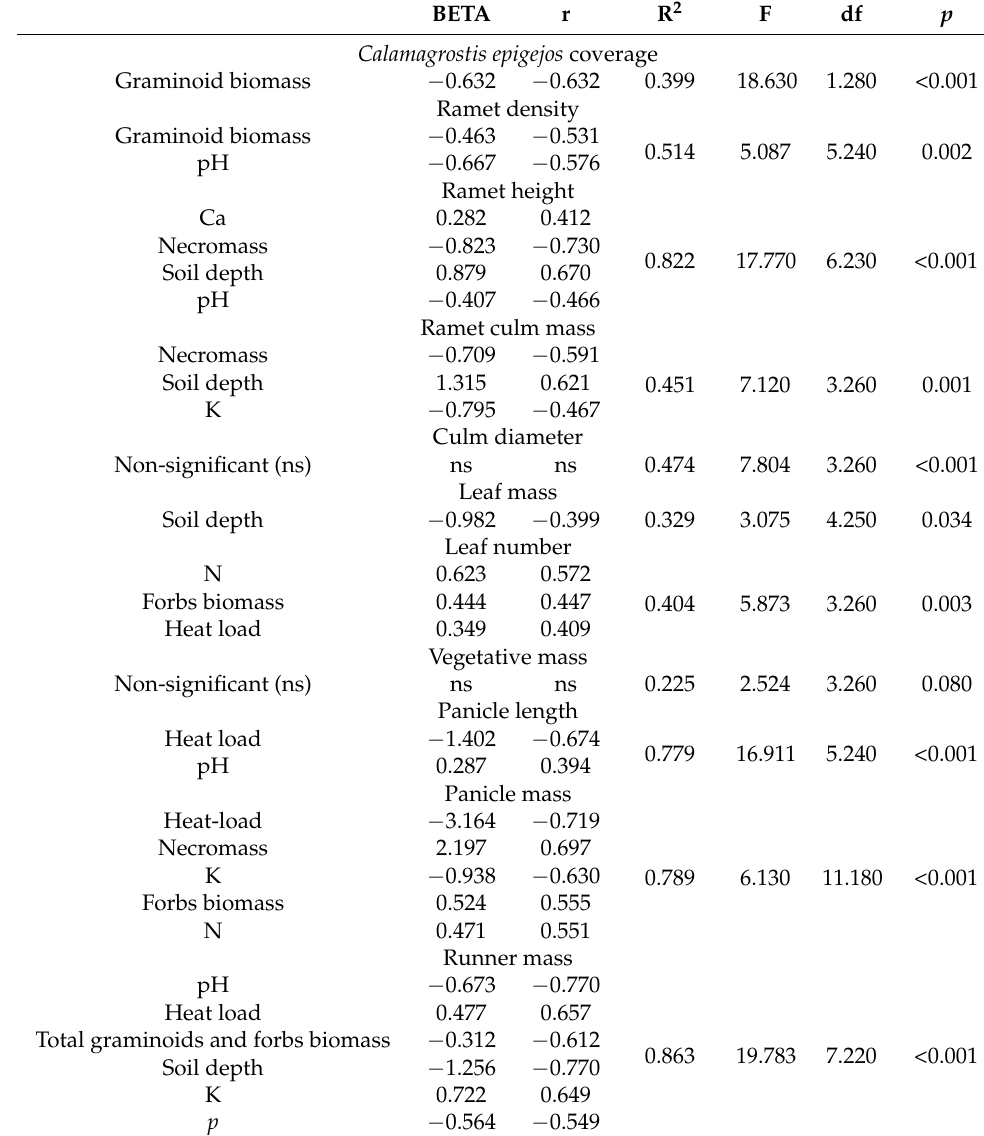
Table 3. Multiple regression results for biometric parameters of Calamagrostis epigejos and habitat factors. The analyses were conducted for ln and transformed